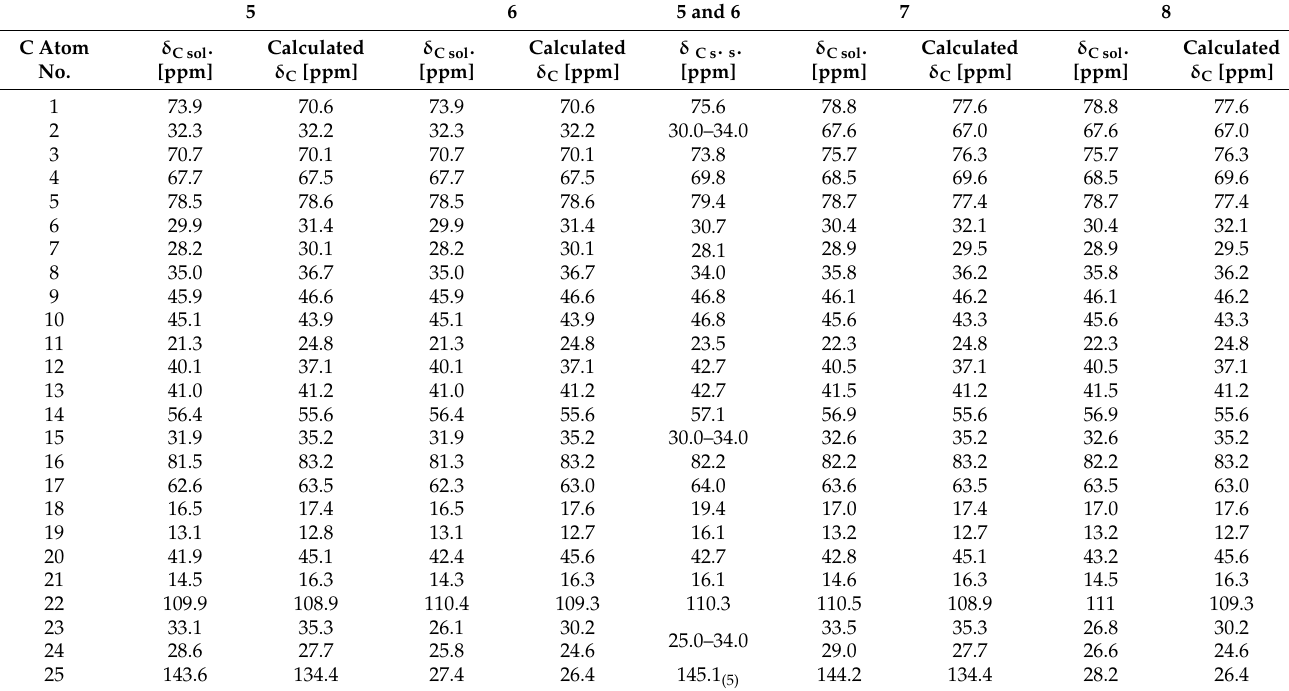
Table 4. 13 C NMR chemical shifts ( δ in ppm) for compounds 5 , 6 (sol: CDCl 3 + CD 3 OD (1:1); s.s.: solid state) and 7 , 8 (sol: CDCl 3 + CD 3 OD (1:1) with the calculated chemical shifts ( δ in ppm) Verification parameters at the bottom of the table: correlation coefficients R 2 and mean absolute errors MAE.